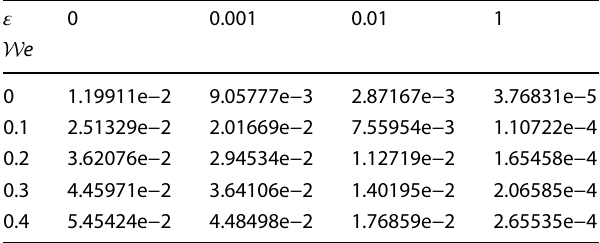
𝜏 12, D − 𝜏 12, N between the 2 ‖ ‖ ‖ ‖